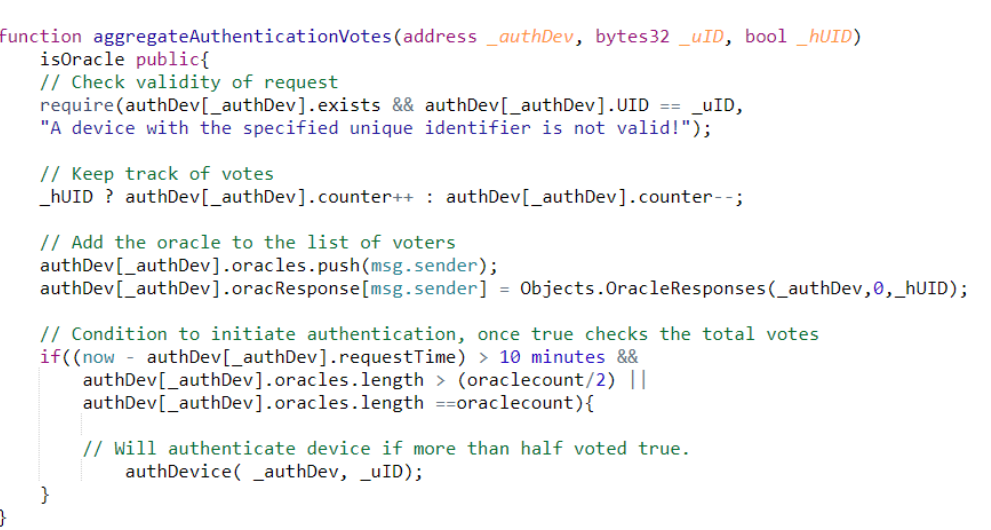
Figure 2. Authentication implementation